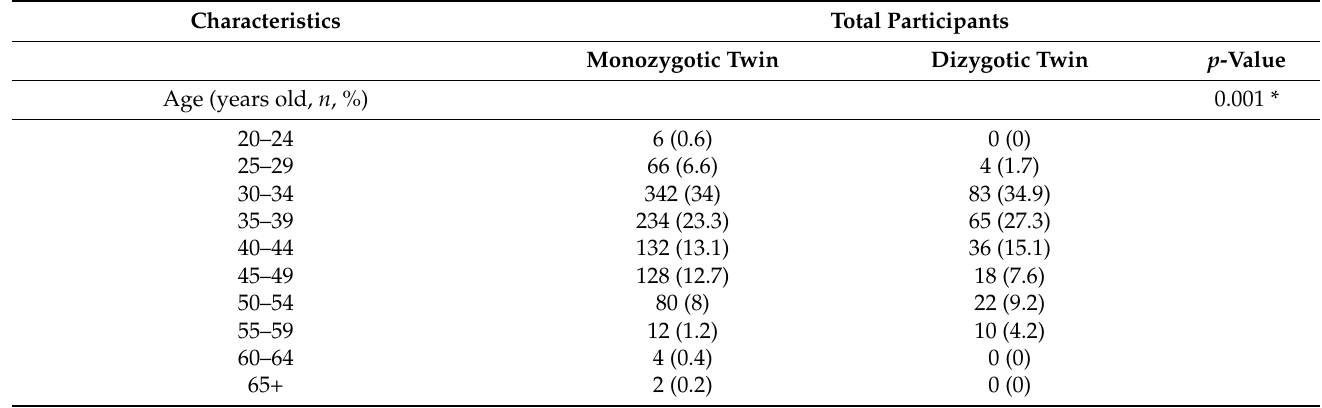
Table 1. Demographic factors and nutritional